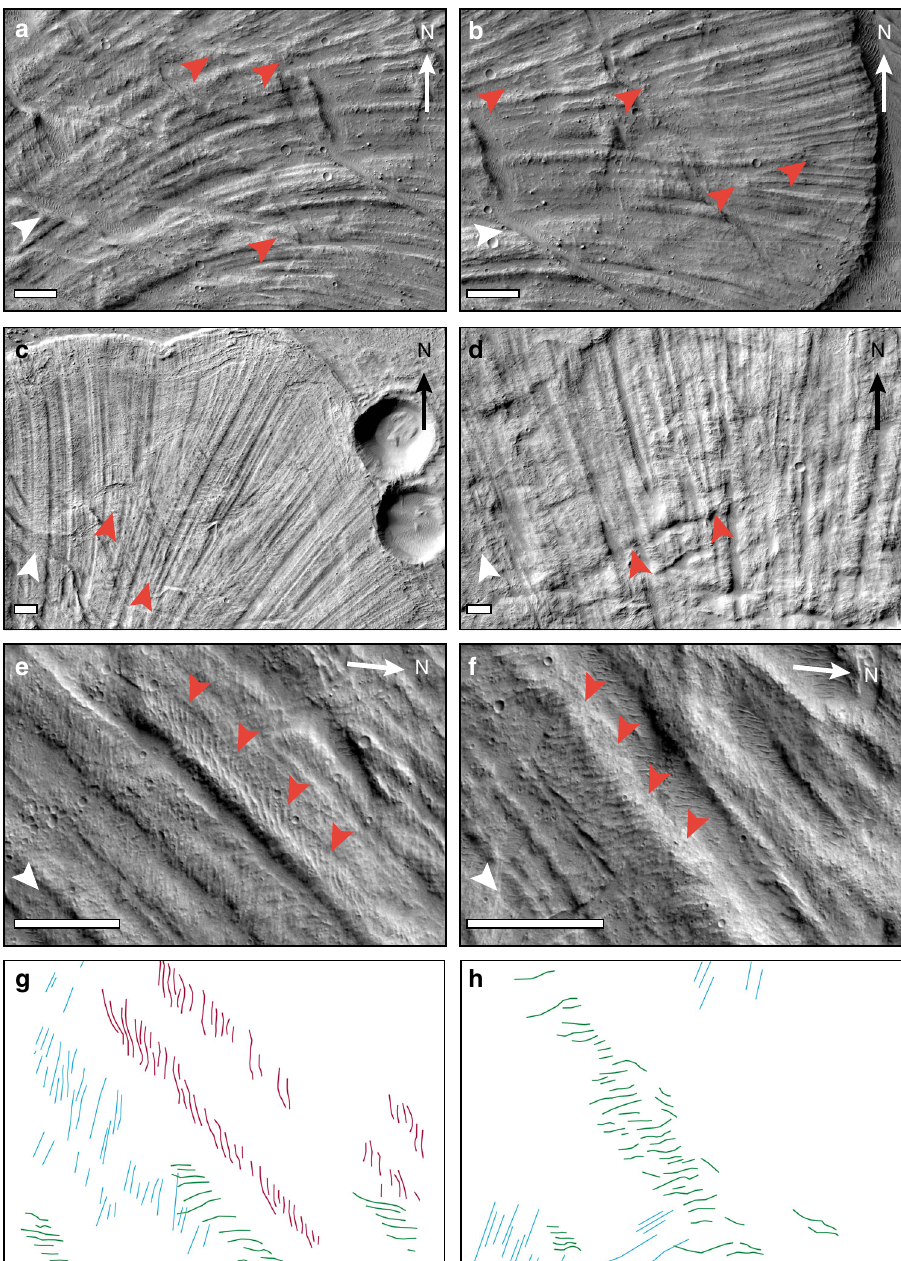
Fig. 3 Close-up images showing the behaviour of longitudinal ridges and superposed en-echelon features. a – d appearance of new, smaller ridges between diverging ridges, as indicated by orange arrowheads; this behaviour may represent fi eld evidence for laboratory observations made by Forterre and Pouliquen 20 , who reported of a complex non-linear evolution that includes transversal drift and creation of longitudinal streaks in rapid granular fl ows. e , f s-shaped en- echelon features superposed on longitudinal ridges; these features may represent kinematic indicators, providing evidence of a velocity gradient between ridges and furrows. g , h Digitalised en-echelon features observed on ridges in ( e ) and ( f ), respectively; red and green colour represent s-shaped features with a rough east-west and north – south orientation, respectively; cyan colour represents other linear features that are not considered in this study. Image (3a), (3b) and (3c) locations are shown in Fig. 1b; location of (3d) is westward to Fig. 1b. White arrowheads indicate fl ow direction. Scale bar is ffiffiffiffiffiffiffiffiffiffi p the central area of study (c) and yellow lines 3 and 4 for the error in the east area of The fl ow velocity u is scaled with g (cid:2) d , where g is the gravitational study (d), represented as error bars in Fig. 2b of the main text: acceleration and d is the grain size, providing the normalised downstream surface velocity ~ u S : ffiffiffiffiffiffiffiffiffiffiffiffiffiffiffi q ð 1 Þ σ ¼ σ 2 þ σ 2 S k i j ffiffiffiffiffiffiffiffiffiffi p ð 2 Þ ~ u S ¼ u g (cid:2) d From the data in Fig. 3 of Börzsönyi et al. 19 , we consider ~ u S ¼ 40, as this is a Velocity estimation . The experimental work of Börzsönyi et al. 19 identi fi ed a value for which the longitudinal ridges develop. We use the gravitational acceleration for Mars, 3.71 m/s 2 , and the largest grain sizes recognisable on the range of scaled downstream surface velocity.